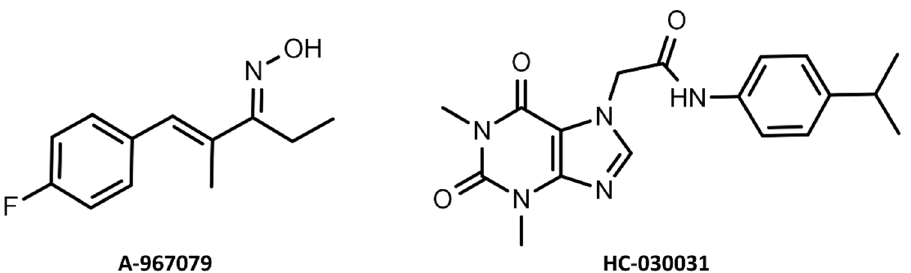
Figure 4. Structure of TRPA1 antagonists: A-967079 and HC-030031 (with a numbering scheme of 1,3-dimethylxanthine core).